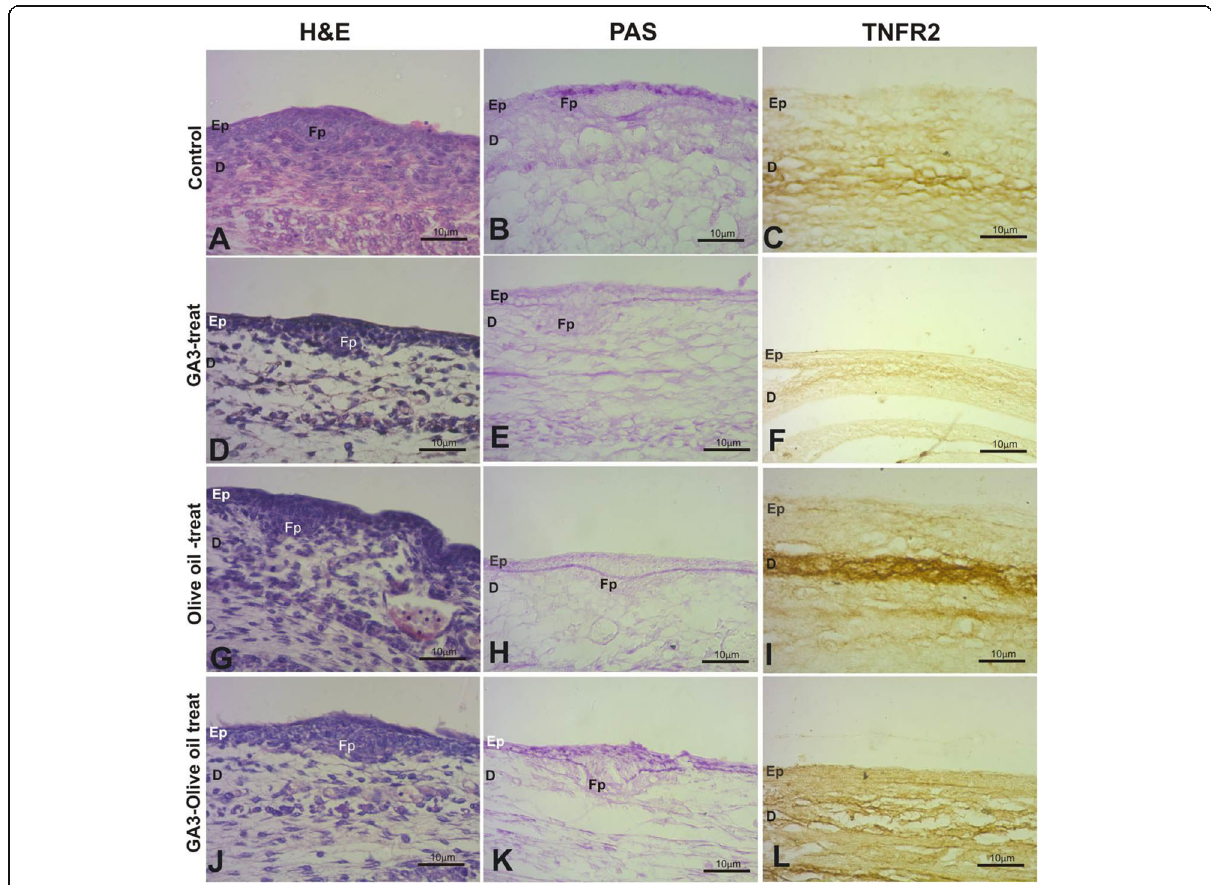
Fig. 8 Photomicrographs of H&E-, PAS-, and TNFR2-stained sections of developing skin at E14. The skin consists of the epidermis (Ep), hair follicles primordium (FP), and dermis. The control skin showed positive carbohydrates in the basement membrane of the FP ( b ) and TNFR2 expression in the dermis ( c ). The skin of GA3-treated embryos showed a thin Ep with poor development of FP, decrease carbohydrate content, and downregulation of TNFR2 expression. The skin of olive oil-treated embryos showed similar structure to the control ( g , h ) but an increase of TNFR2 expression was observed ( i ). Improvement in the histopathological changes was noted in the skin of GA3-olive oil-treated embryos ( j – l ). Scale bar ( a – l ) = 10 μ